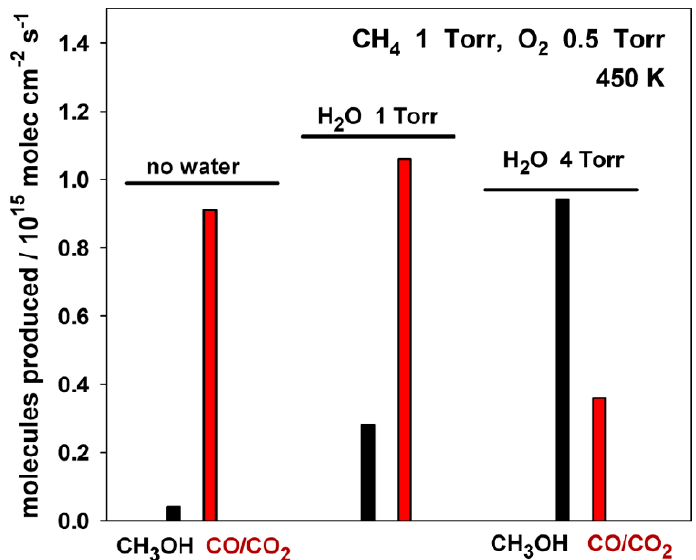
Figure 17. Production of CH 3 OH and CO/CO 2 as a function of water pressure on a CeO 2 /Cu 2 O/Cu(111) catalyst in which ∼ 40% of the Cu 2 O was covered by ceria. The samples were exposed to 1 Torr of CH 4 , 0.5 Torr of O 2 and 0, 1, or 4 Torr of H 2 O at 450 K in a batch reactor. Reprinted with permission from [96]. Copyright 2016 American Chemical Society.